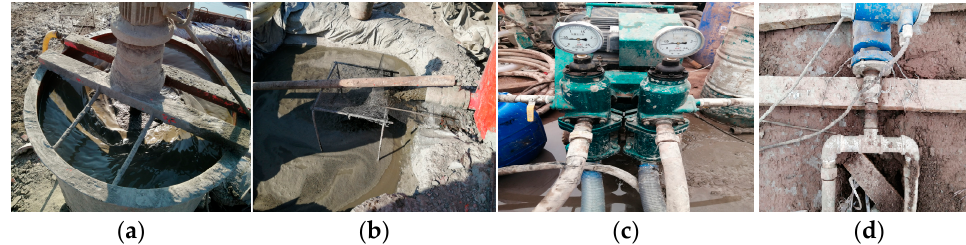
Figure 9. Grouting system: ( a ) slurry agitator; ( b ) reserve pit; ( c ) grouting pump; ( d ) slurry flow meter.